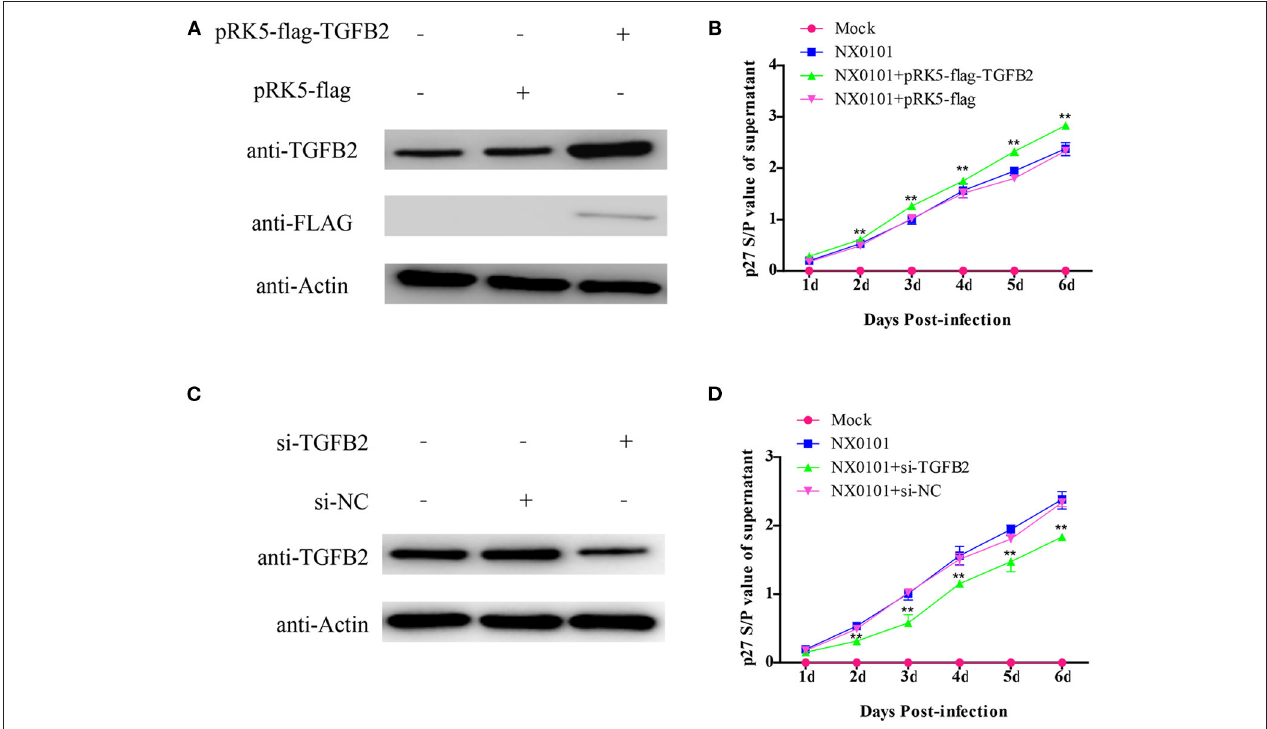
FIGURE 10 | Effects of TGFB2 on ALV-J replication. (A) Expression levels of TGFB2 protein were analyzed by Western blotting 24h after transfection of DF-1 cells with pRK5-flag-TGFB2 or pRK5-flag; (B) viral growth curve assay in DF-1 cells transfected with pRK5-flag-TGFB2 or pRK5-flag; (C) expression levels of TGFB2 protein were analyzed by Western blotting 24h after transfection of DF-1 cells with siRNA targeted to TGFB2 or si-NC; (D) viral growth curve assay in DF-1 cells transfected with si-TGFB2 or si-NC. Data represent means ± SE. ** p <